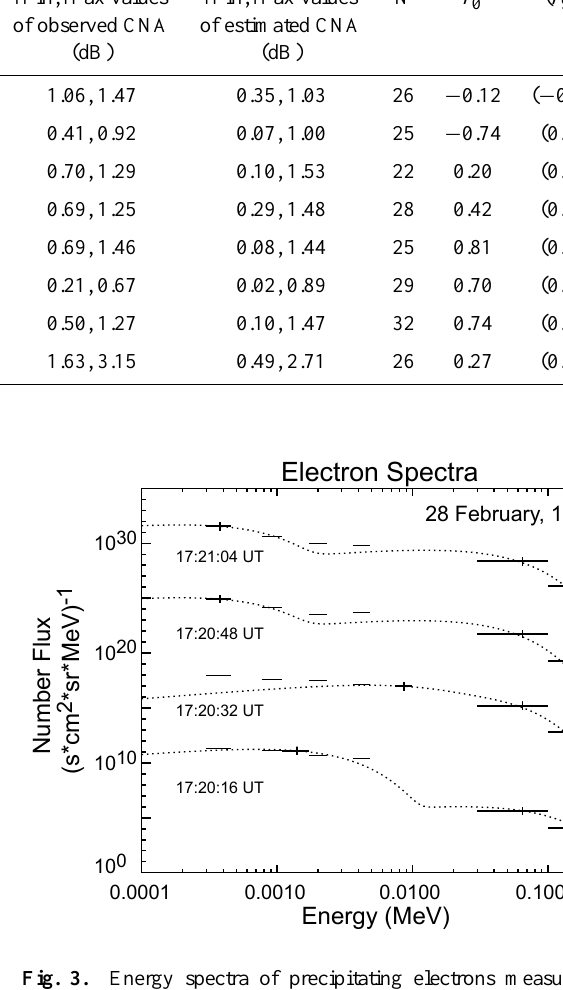
Table 1. The events selected to evaluate the correlation coefficient between observed and estimated CNA. We selected the eight events for which both the observed and estimated CNA had a range of variation larger than 0.4dB. The N indicates the number of data points of each event. The r 0 ( r 90 ) shows the correlation coefficient between observed and estimated CNA from the precipitating (trapped) electron flux. No.